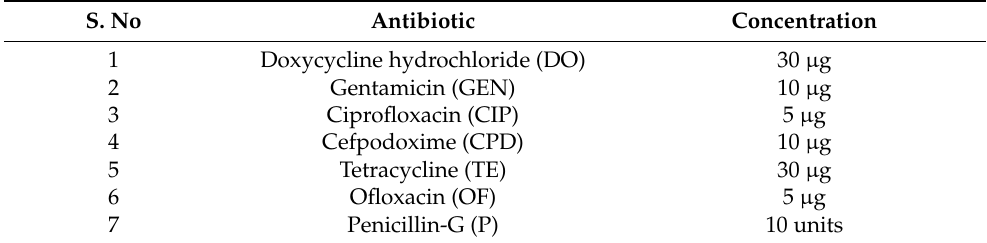
Table 9. Antibiotics with their